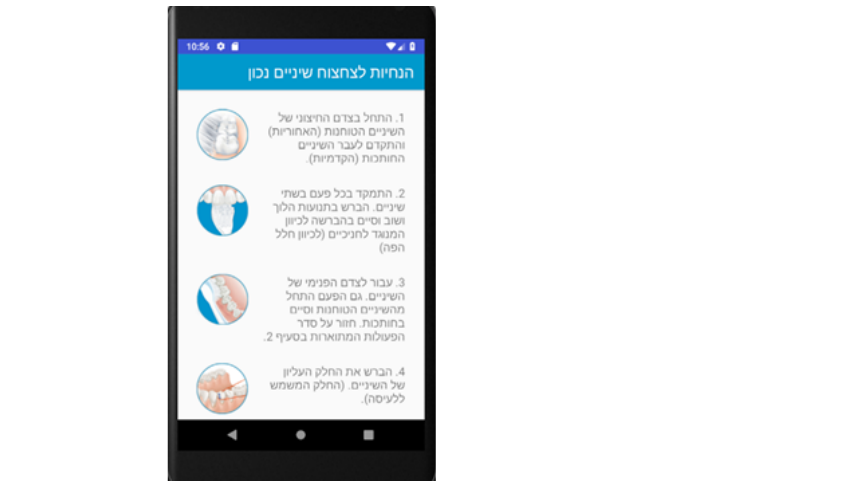
Figure 14. Tutorial screen for the patient: brushing your teeth.